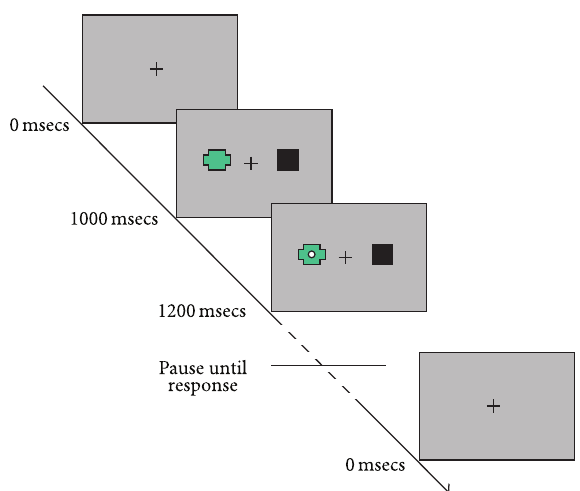
Figure 1: Representation of the sequence of events of a single trial in the novelty attention